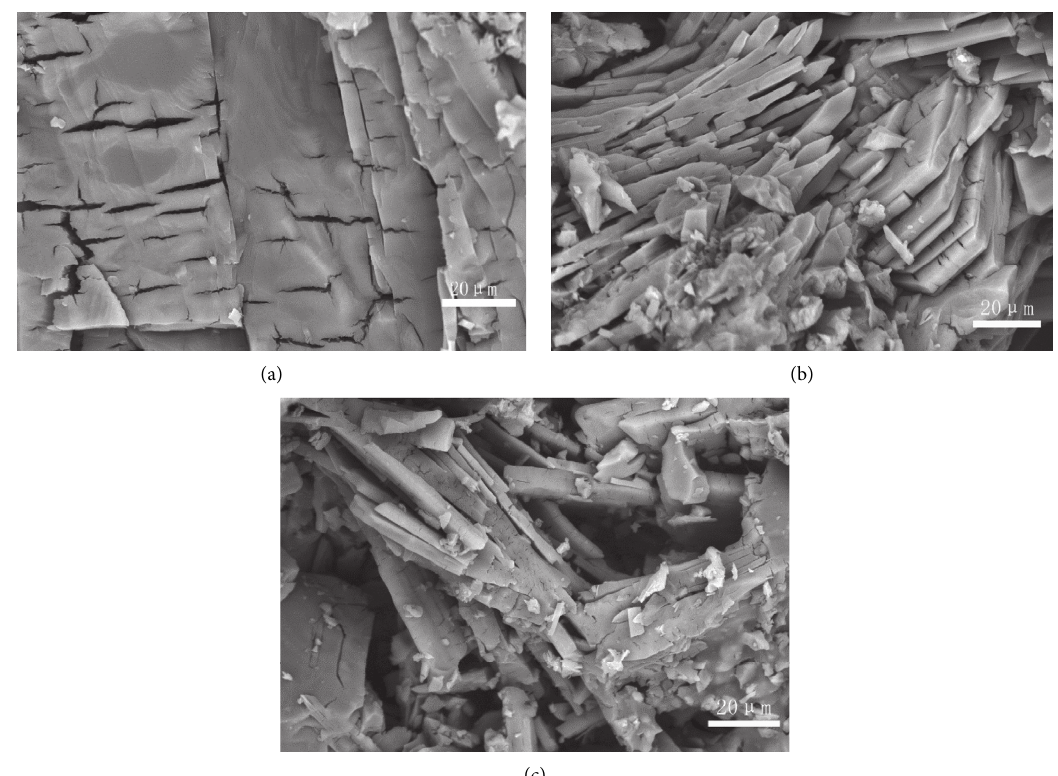
Figure 13: The microstructure of the samples cured under air-curing conditions for 28d. (a) M / P � 3 :1, (b) M / P � 4:1, and (c) M / P � 5:1.